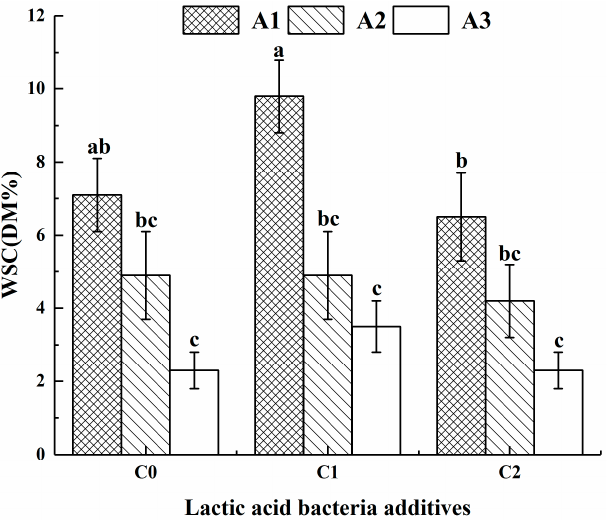
Figure 2. Differences in the average WSC content for the interaction between forage species and lactic acid bacteria additives. Different letters mean significant differences at p < 0.05. WSC: water-soluble carbohydrate; A1: triticale; A2: rye; A3: oat; C0: additive-free treatment; C1: Sila-Max; C2: Sila-Mix. Table 4. Differences in the average silage fermentation quality for the interaction between forage species and lactic acid bacteria